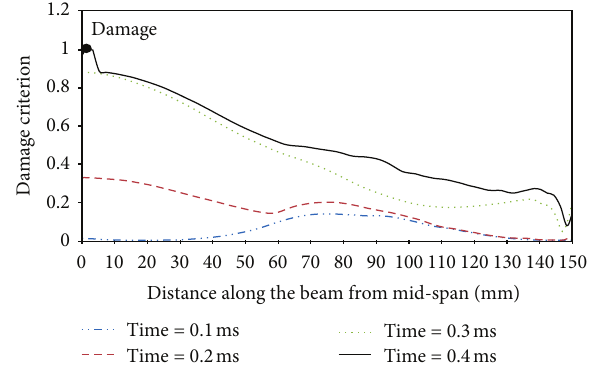
Figure 12: The damage evolution of the CFRP along the beam span for half of the